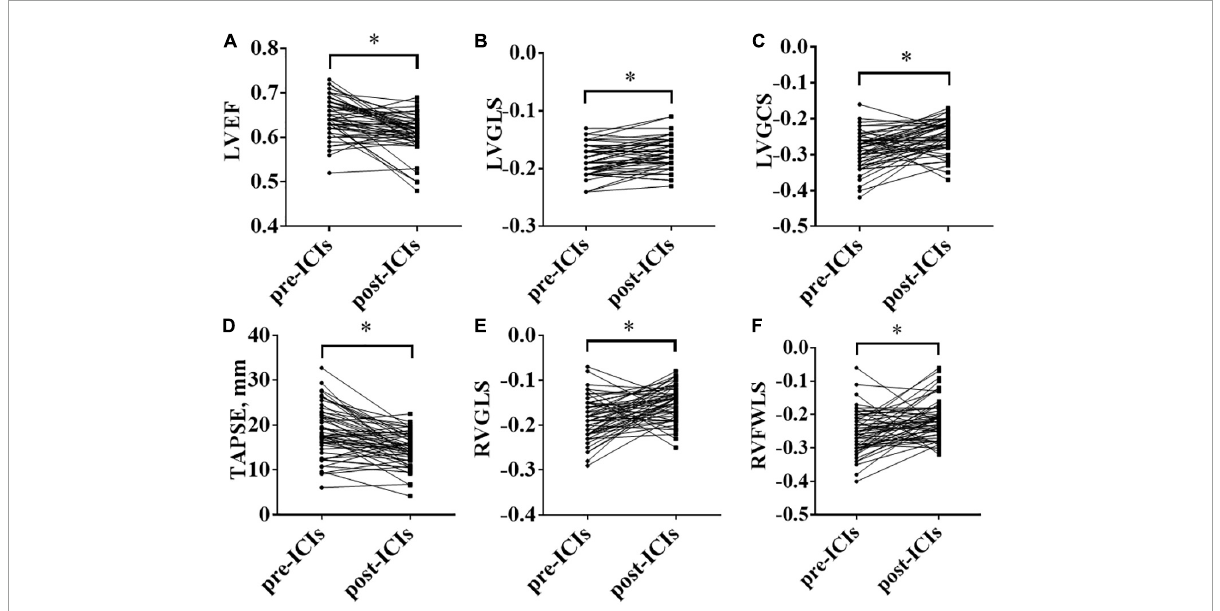
FIGURE1 Changes in left ventricular ejection fraction (LVEF), left ventricular global longitudinal peak systolic strain (LVGLS), left ventricular global circumferential peak systolic strain (LVGCS), tricuspid annular plane systolic excursion (TAPSE), right ventricular global longitudinal systolic strain (RVGLS), and right ventricular free-wall longitudinal peak systolic strain (RVFWLS) before and after immune checkpoint inhibitors (ICIs) treatment; (A) : LVEF; (B) : LVGLS; (C) : LVGCS; (D) : TAPSE; (E) : RVGLS; (F) : RVFWLS; ∗ P <